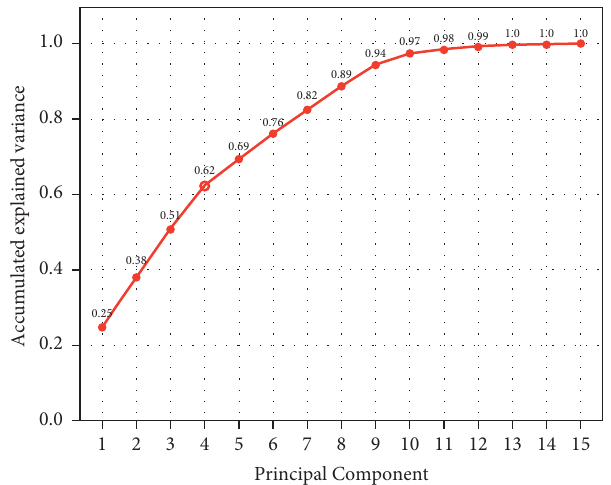
Figure 3: The accumulated explained variance associated to the PCA components.